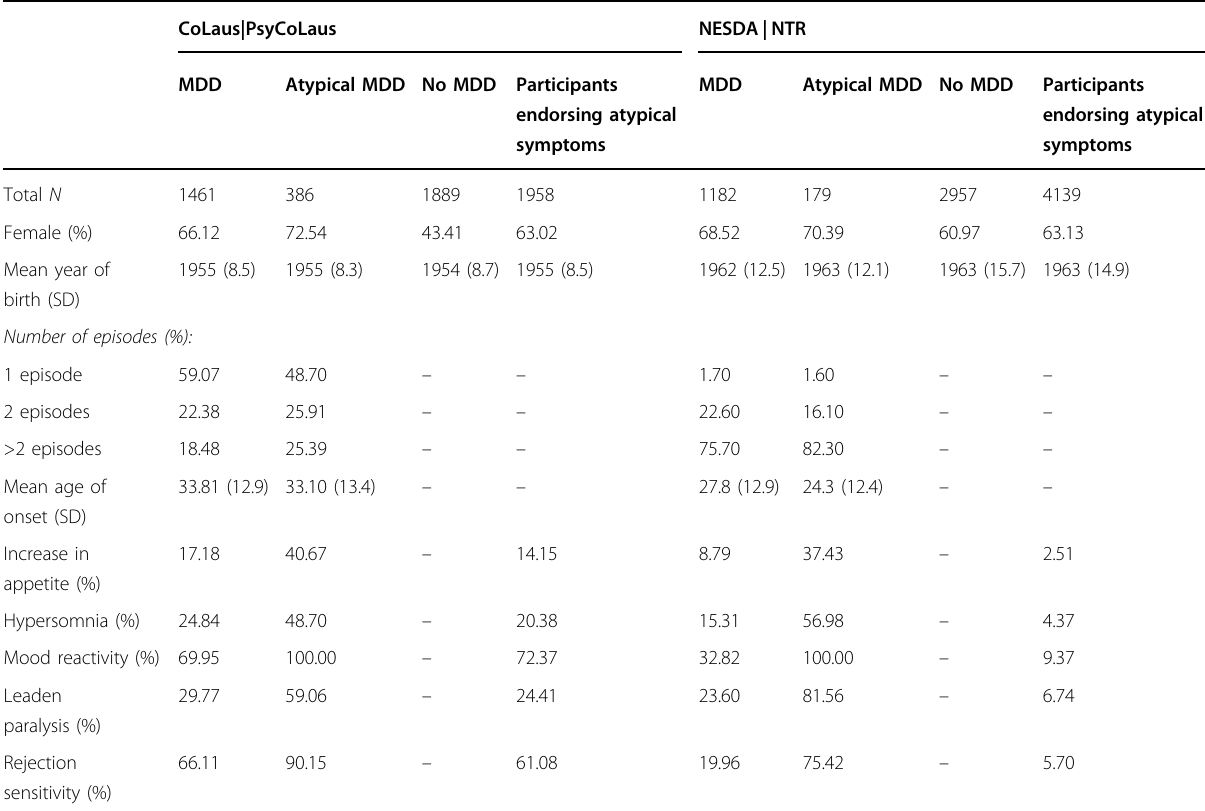
Table 1 Demographic and clinical characteristics and distribution of atypical symptoms in CoLaus|PsyCoLaus and